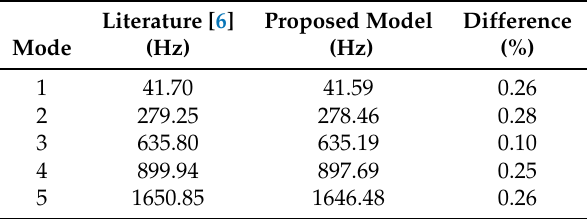
Table 3. Comparison of analytical results: Clamped-pinned-free (pinned at a = 200 mm) (Case 3).